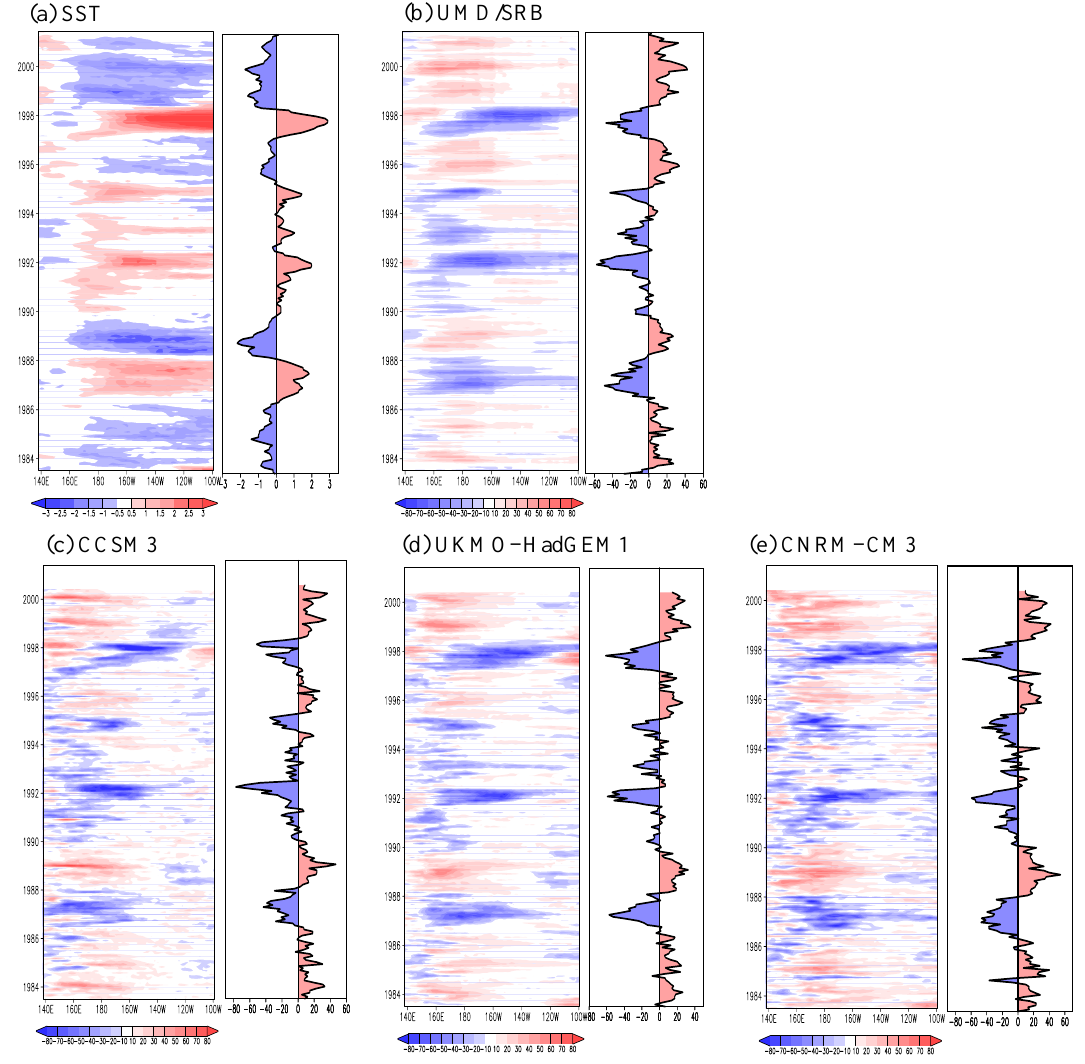
Fig. 5. Time-longitude plot (Hovm¨oller representation) of the departures of the mean over 5 ◦ S to 5 ◦ N for: (a) SST ( ◦ C), and SW ↓ surf for the following (b) UMD/SRB; (c) CCSM3; (d) UKMO-HadGEM1; (e) CNRM-CM3 in Wm − 2 . The figures to the right of each Hovm¨oller plot present time series of respective parameters averaged over El Ni˜no 3.4 region for SST and over El Ni˜no 4 region for SW ↓ surf .